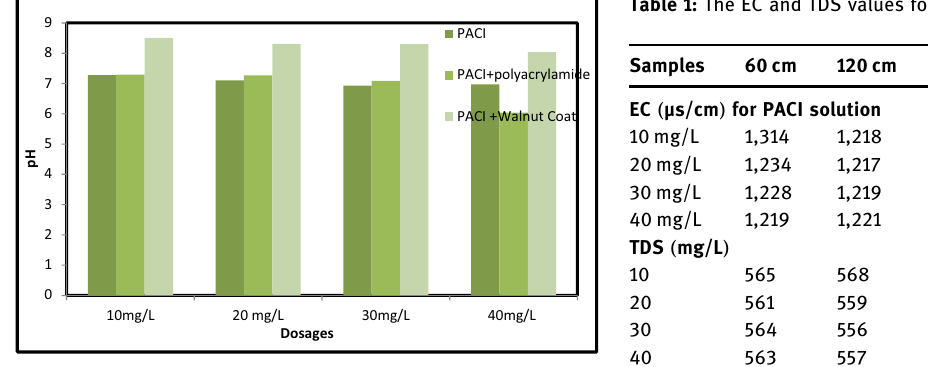
Table 1: The EC and TDS values for PACl solution